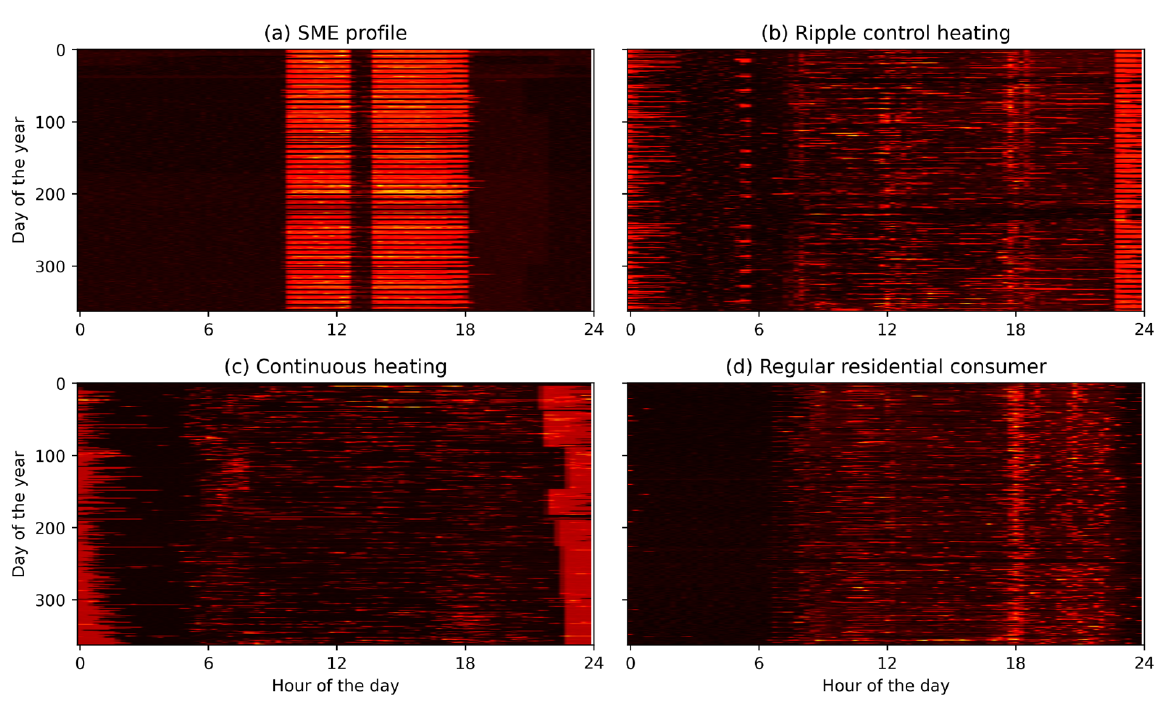
Figure 1. Examples of heatmaps for four different types of consumers on the low-voltage grid: ( a ) an SME profile, ( b ) a consumer with ripple control electric heating with a fixed start time of the heating, as well as differences between weekdays and weekends, ( c ) a consumer with continuous electric heating, and ( d ) a regular residential